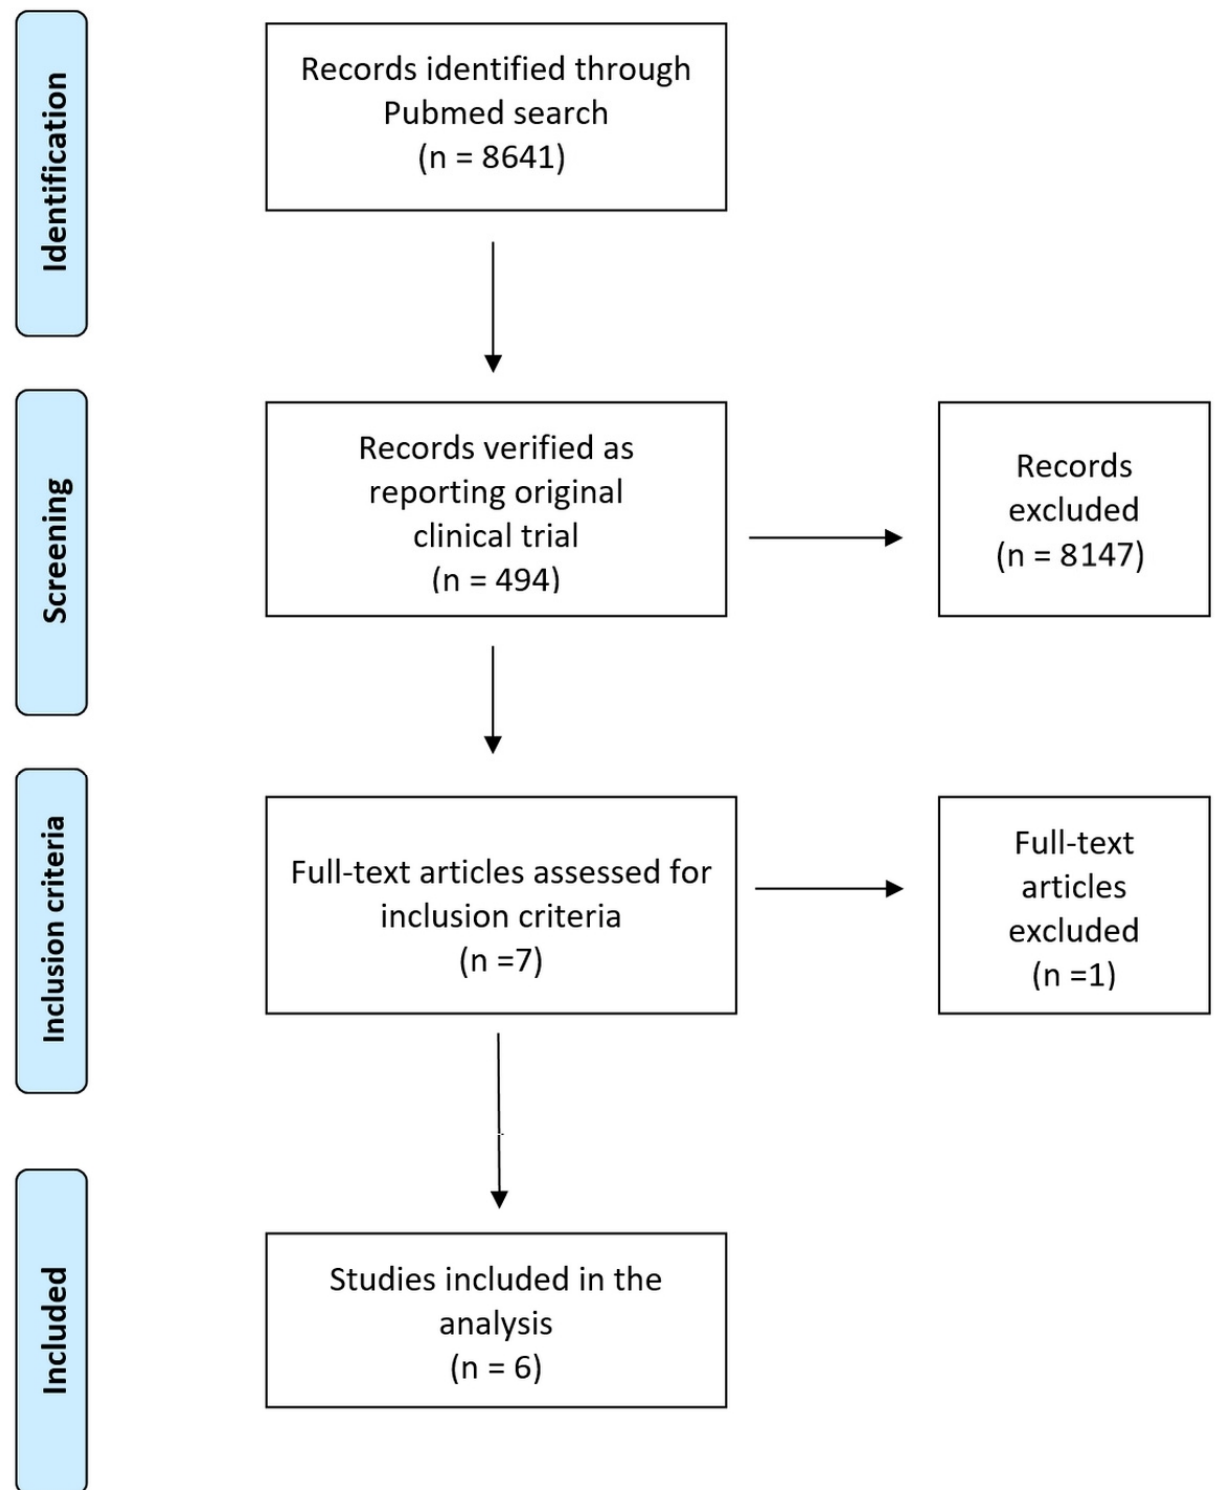
Figure 1. PRISMA flow chart summarizes the literature search.